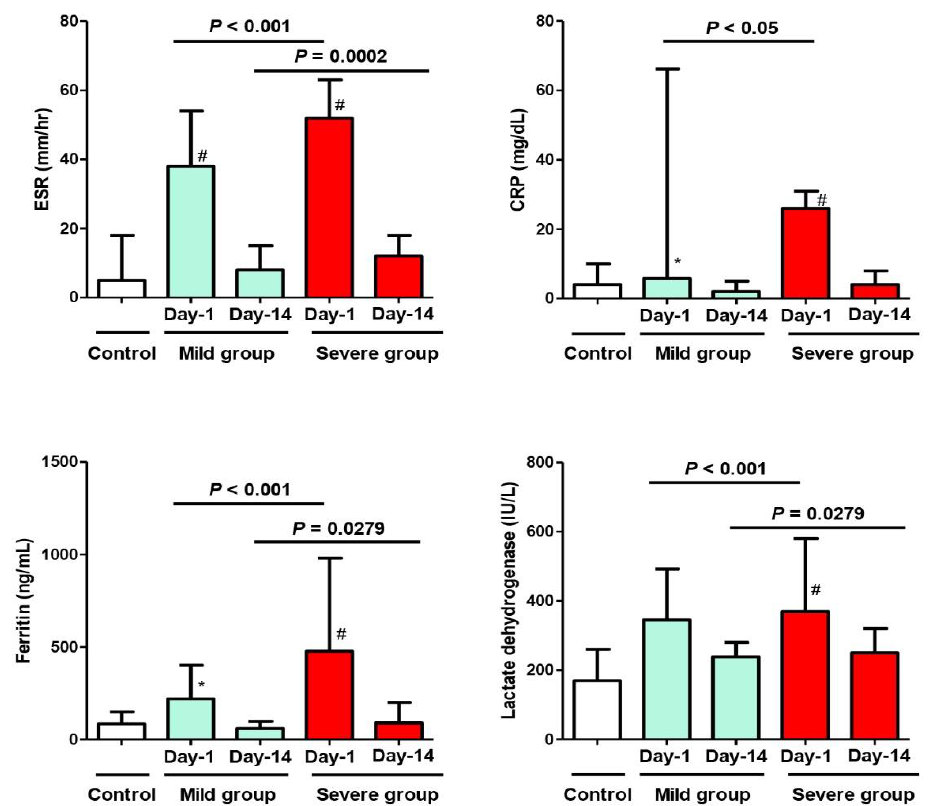
Figure 1. Changes in the inflammatory parameters (ESR, CRP, Ferritin, LDH) of the study cohort on Day 1 and Day 14 after admission with MIS-C manifestations. Control Group = Simple COVID-19 infection; Group A = Mild MIS-C; Group B = Severe MIS-C. ESR: Erythrocyte sedimentation rate; CRP: C-reactive protein; LDH: Lactate dehydrogenase. * p < 0.05 and # p < 0.01, statistically significant difference compared to the control group (one-way ANOVA followed by Tukey’s post-test).